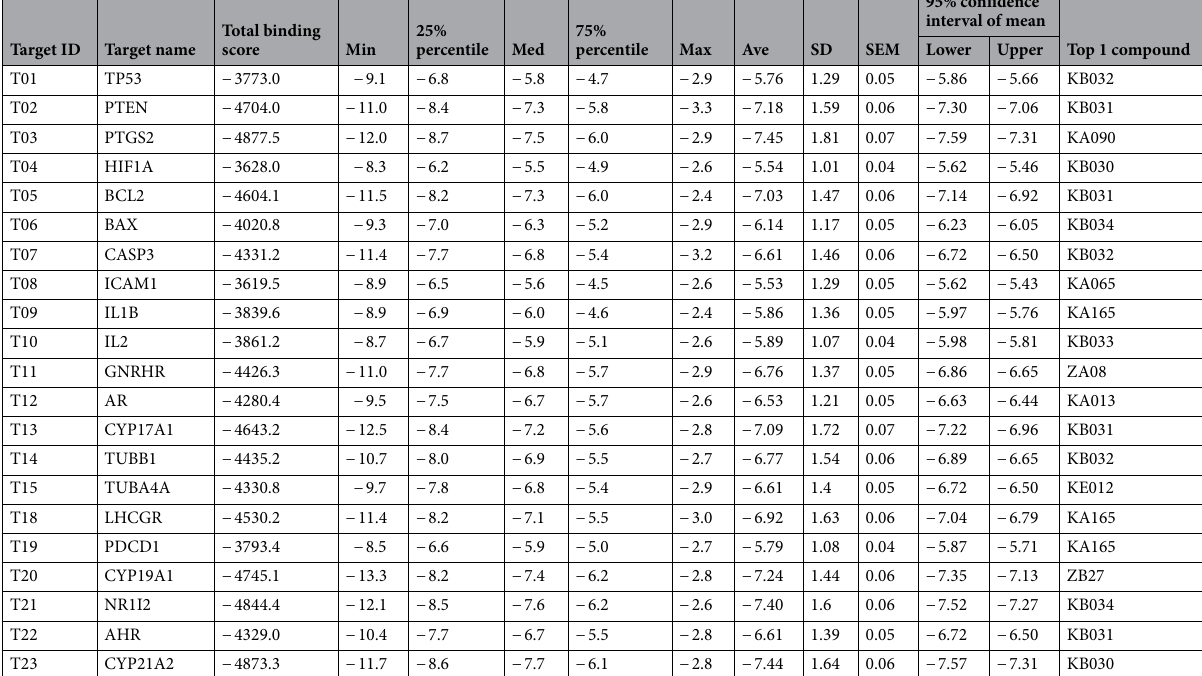
Table 2. Details of docking results between 621 natural compounds from Danggui Beimu Kushen Wan and 21 targets for prostate cancer (kcal/mol). Corresponding target full names refer to Table 1.